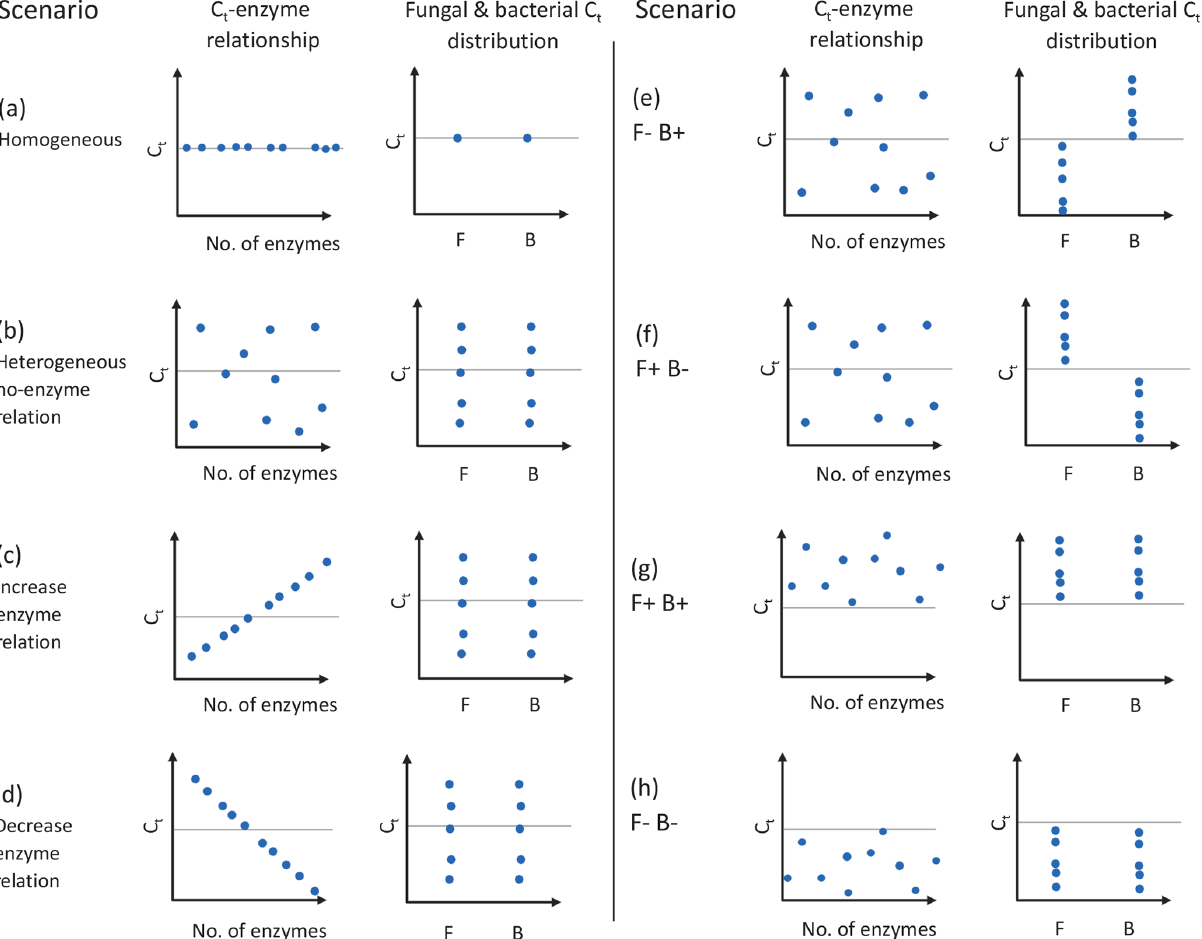
Figure 1. Schematic of experimental design used in this study, where the CUE temperature response ( C t ) varies as a function of the number of enzymes and/or taxonomic affiliation of organisms. Graphs show the effects of having homogeneous (a) or heterogeneous (b) C t across taxa, the effect of forcing a positive (increase; c ) or negative (decrease; d ) correlation between the number of enzymes and C t , bacteria showing a positive C t and fungi a negative C t (e) , fungi showing an positive C t and bacteria a negative C t (f) , or fungi and bacteria both having positive (g) or negative (h) C t . Each point represents the combination of traits 1 of 10 taxa in the model might have, although 100 taxa were actually used in the simulations. Horizontal dashed lines indicate a C t of zero, and clusters of points above and below this line denote when CUE tends to increase or decrease with increasing temperature. The letters F and B in the x axis of individual graphs denote sensitivities for fungi and bacteria, respectively. The trait values for different mock taxa may not be visible if the values for the traits on the two axes are identical. Figure prepared in